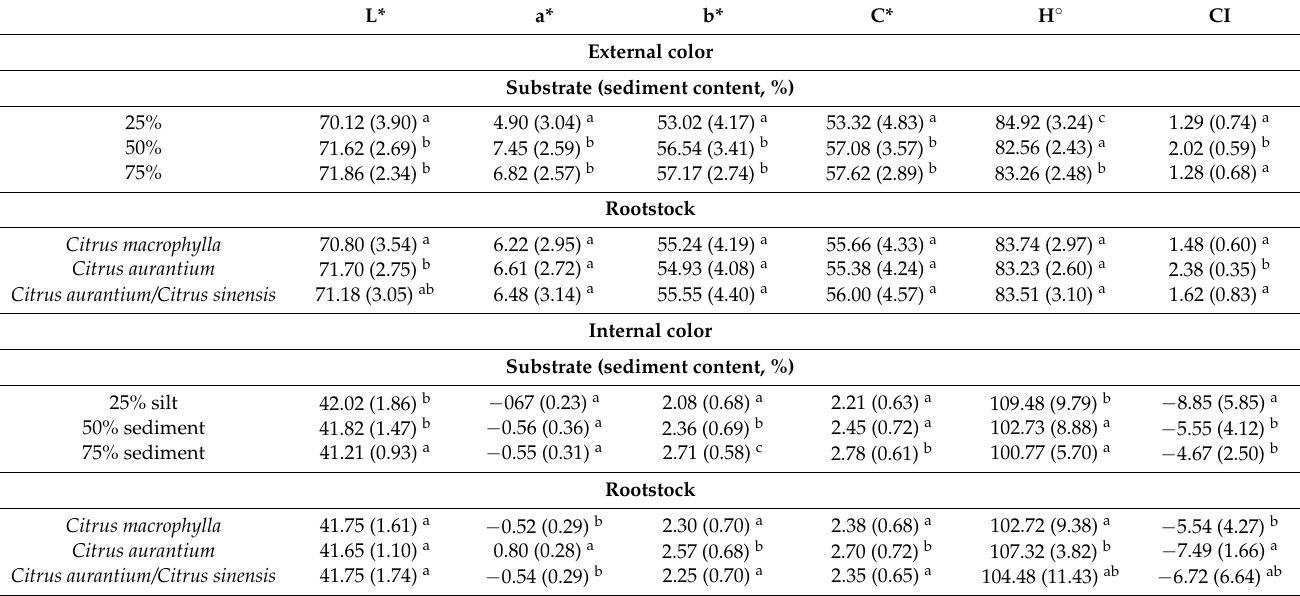
Table 4. Peel and juice color variations of ‘Verna’ lemons obtained on different rootstocks and substrates, where L* represents luminosity, a* green/red, b* blue/yellow, C* chroma values, H ◦ the hue angle, and CI the citrus color index. The values represented are the mean with their standard deviation in